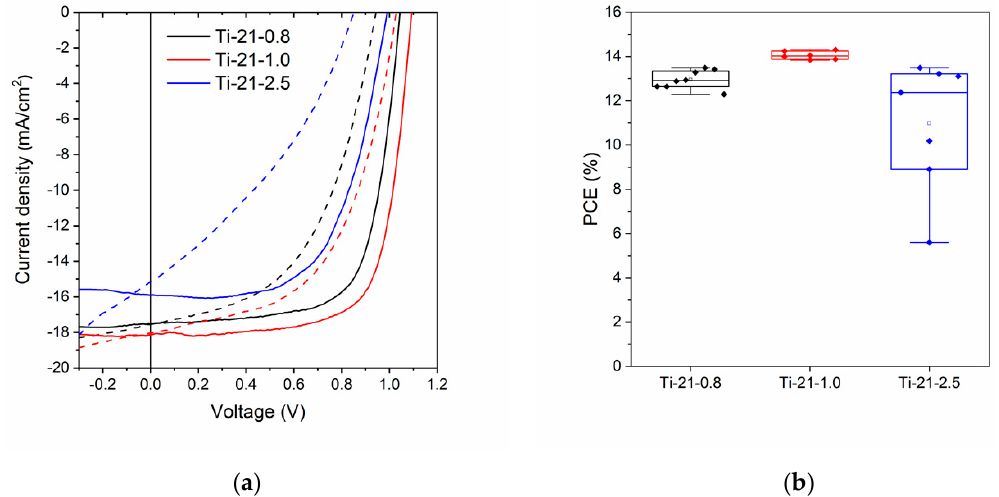
Figure 5. ( a ) J-V curves for representative devices based on TiO 2 ESLs with the highest porosity with different thicknesses. Dashed lines indicate forward sweep and solid lines reverse sweep; ( b ) box chart for the efficiencies in reverse sweep.